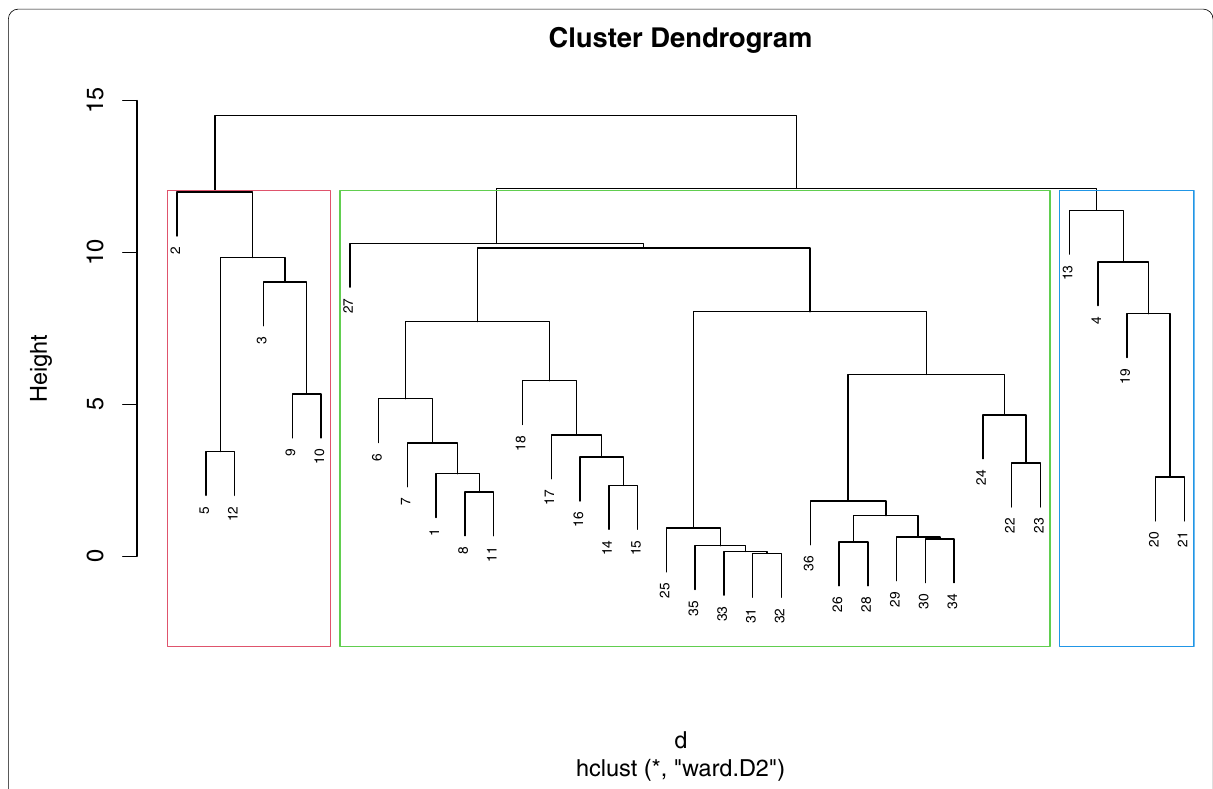
Fig. 3 Dendrogram of similarity by hierarchic cluster analysis using the block‑distance measure, and Ward’s clustering method between the different evaluated areas based on abundance, on the analysis. Red box: Control area, green box: Unassisted ecological succession area and blue box: Assisted ecological succession area